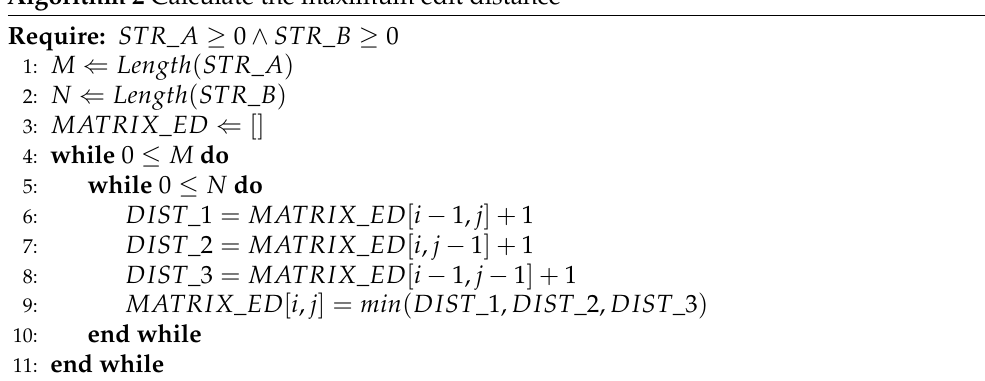
Algorithm 2 Calculate the maximum edit